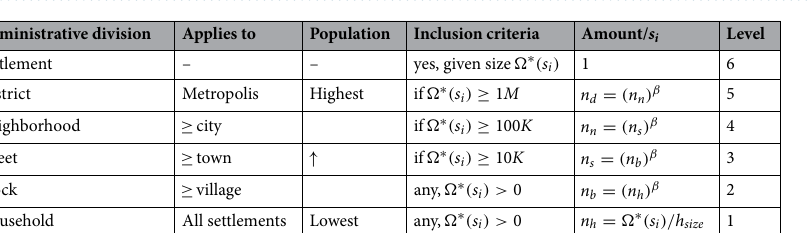
Figure 1. Yearly epidemic size φ y distributions normalized by the population of each administrative region for: influenza in counties of Germany ( a ), influenza in counties of California ( b ), global H1N1 ( c ), measles in Indonesia ( d ), pertussis in California ( e ) and global COVID-19 cases ( f ). Representative modes are detected, in all examples, for small outbreaks (e.g., φ y < 0.02 in f) followed by a relatively uniform distribution of larger epidemic sizes (e.g., 0.02 < φ y < 0.06 in f). The insets summarize the cumulative frequency distributions CFD, quantifying the amount of epidemics sized ≤ φ y , on log-log axes. Fitting a power-law over the flatter regions (orange line) results in exponents γ = 0.55 − 1.05 .